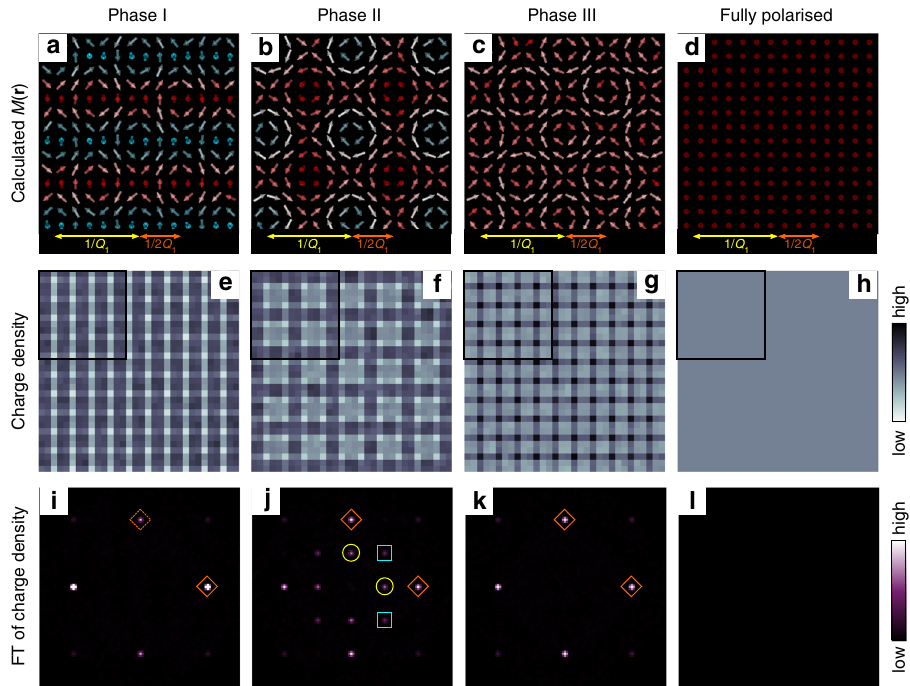
Fig. 4 Magnetic and electronic structure by the model calculation. a – d Calculated local magnetic moments M ( r ) in different magnetic phases. Red (cyan) colour represents the magnetic moments pointing (anti)parallel to the magnetic fi eld. e – h Calculated charge-density patterns in different magnetic phases. The regions shown in ( a ) – ( d ) are marked with black squares. i – l FTs of ( e ) – ( h ). Coloured symbols correspond to those in Fig.